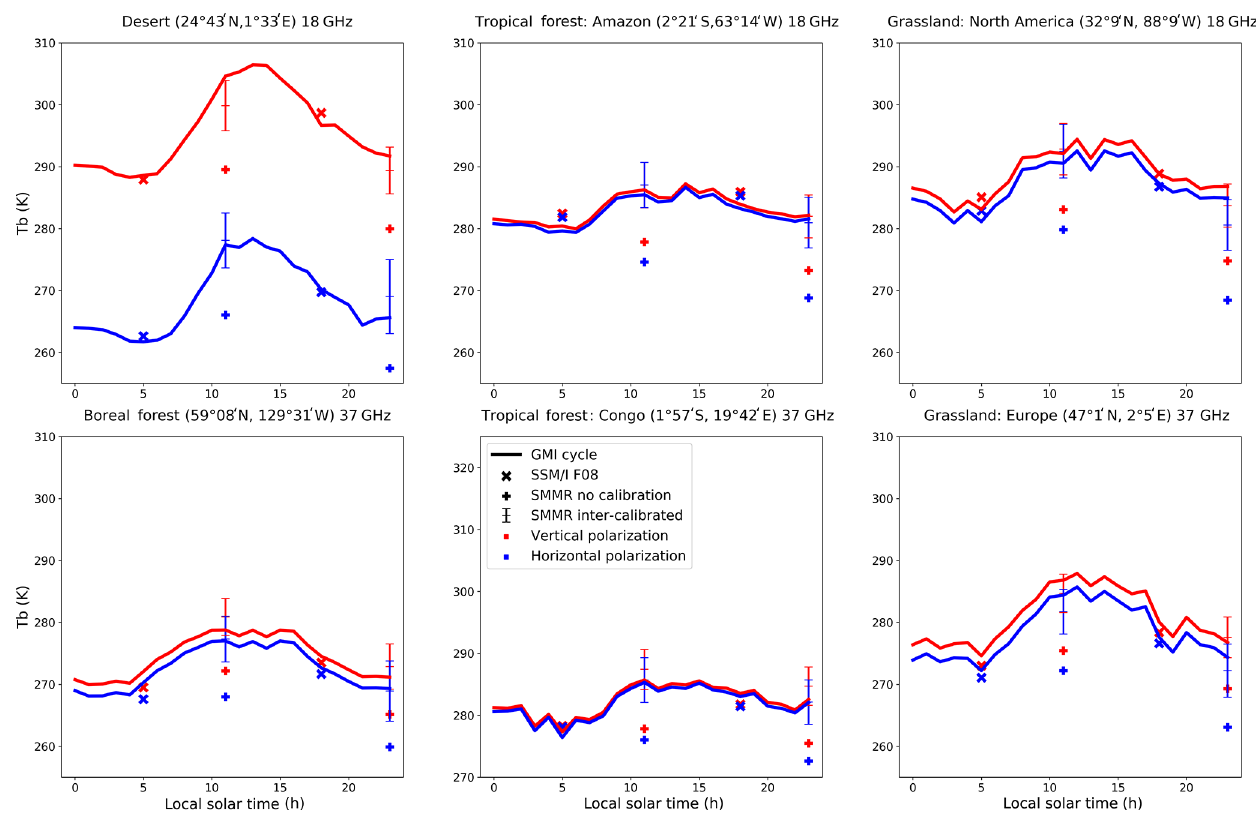
Figure 4. Diurnal cycle of GMI in July/August compared to values measured by SMMR with and without the proposed correction, and SSM/I values for the months of July/August 1987 over various locations and at different